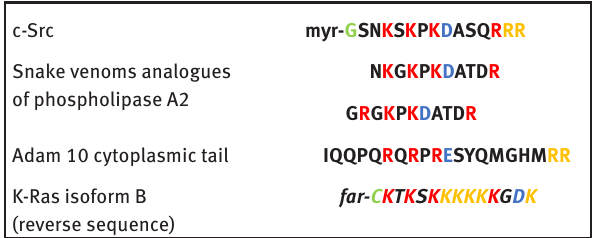
Table 1: Putative phospholipid binding sequences in disordered